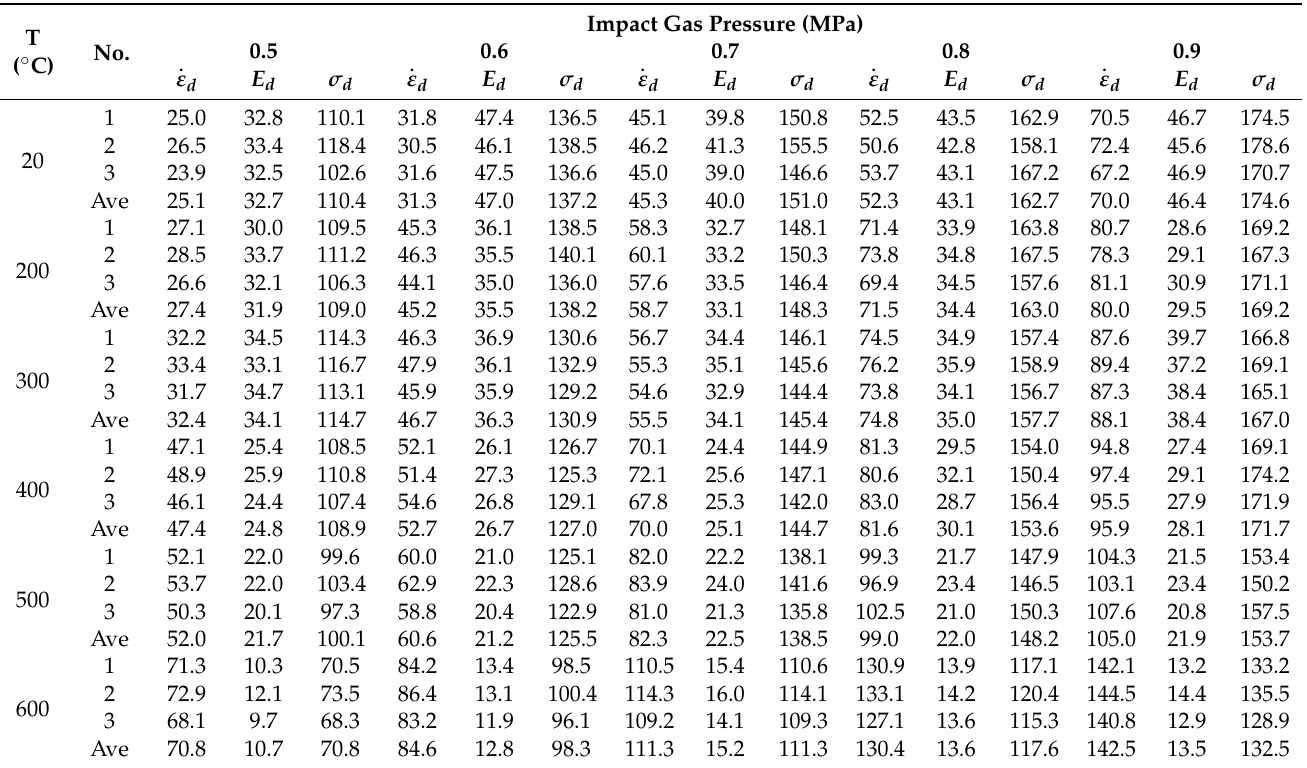
Table 2. Dynamic mechanical parameters of specimens at different temperature and gas